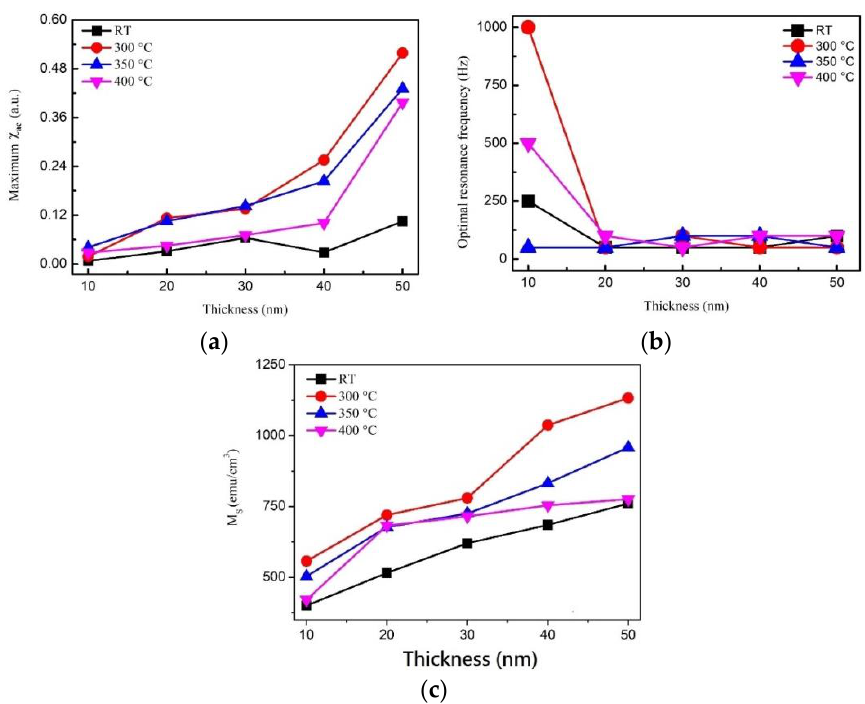
Figure 7. ( a ) The maximum alternate-current magnetic susceptibility of CoFeW thin films. ( b ) The optimal resonance frequency of thin films with different thicknesses. ( c ) Saturation magnetization ( M s ) of CoFeW thin films.